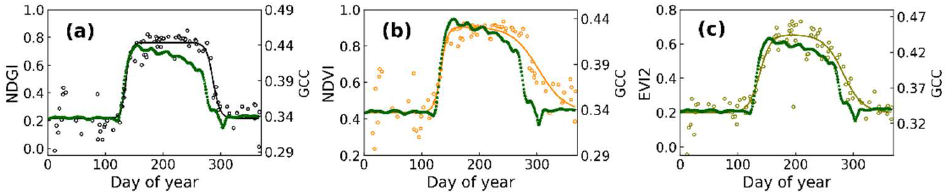
Figure 7. Comparison of greenness trajectories from SGLI in different vegetation indices, including NDGI ( a ), NDVI ( b ), and EVI2 ( c ) with near-surface GCC.